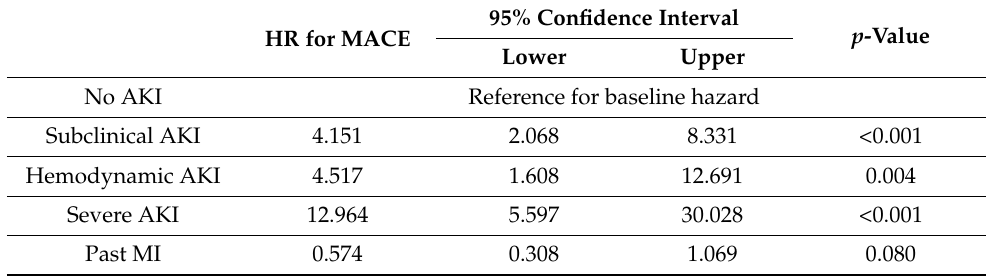
Table 2. Multivariate regression for the occurrence of any